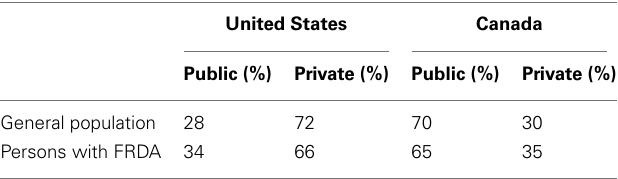
Table 3 | Public and private funding ratios in the United States and Canada for the general population and for persons with